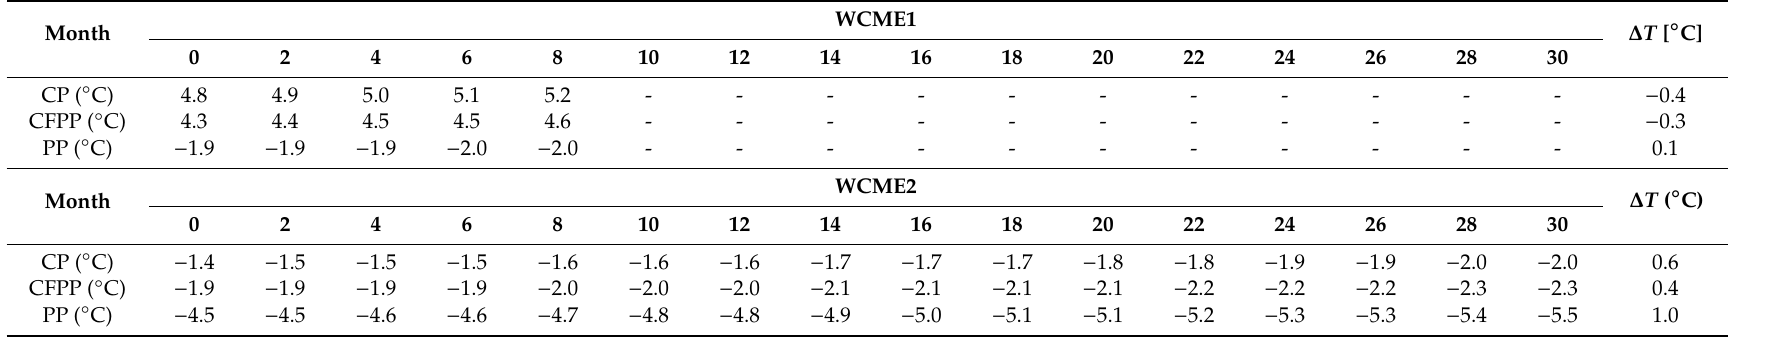
Table 5. Influence of storage period (months) on cold flow properties of WCME1 and